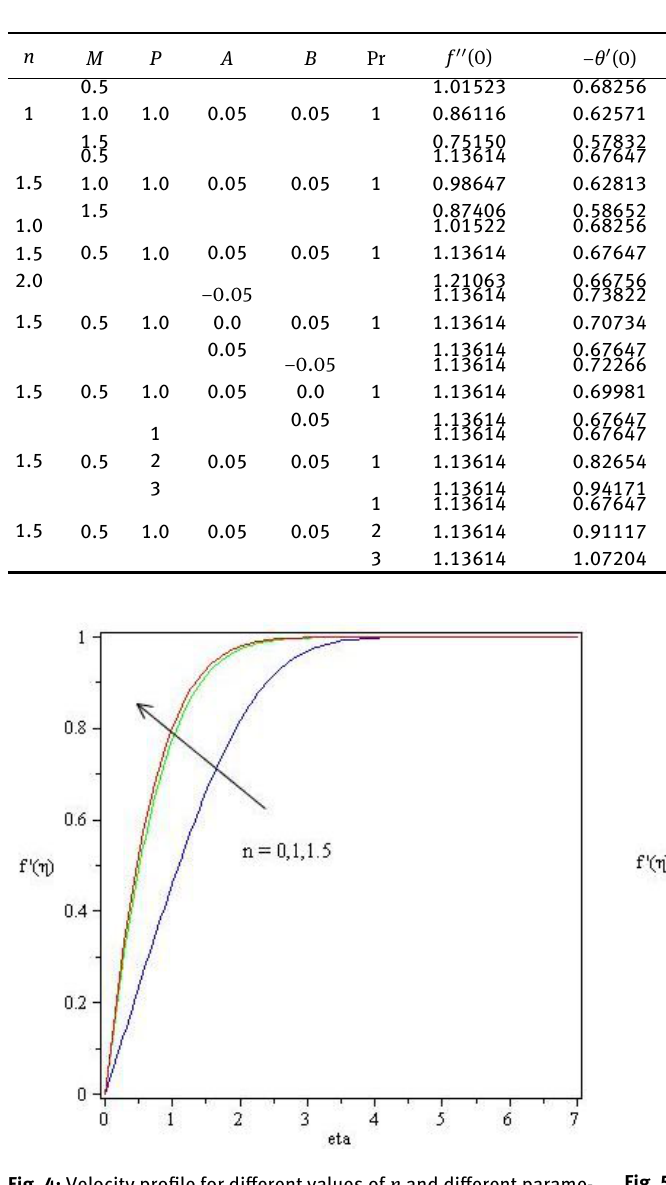
Table 2: The Numerical values of Local Skin-Friction and Local Nusselt number